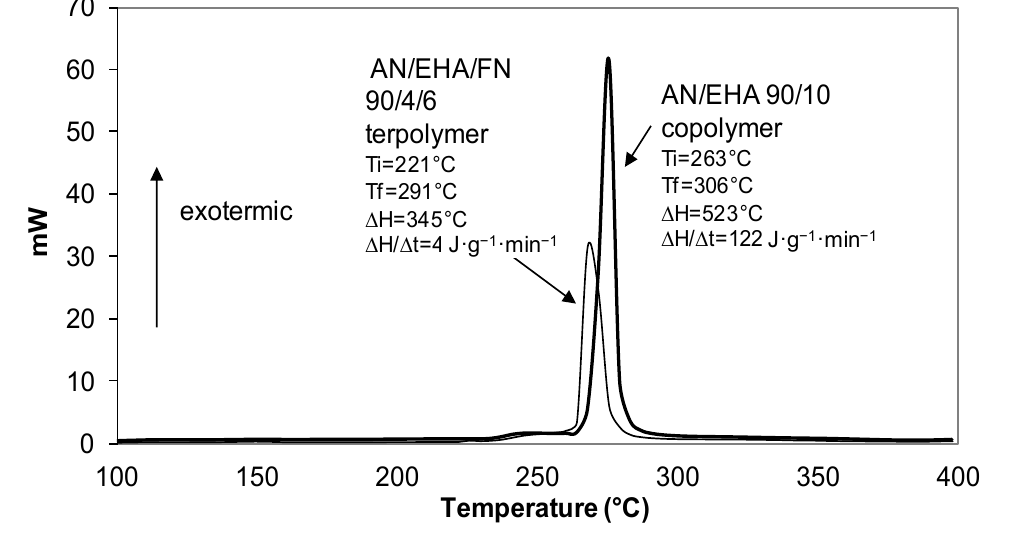
Figure 5. DSC thermograms of AN/EHA 90/10 copolymer and AN/EHA/FN 90/4/6 terpolymer.